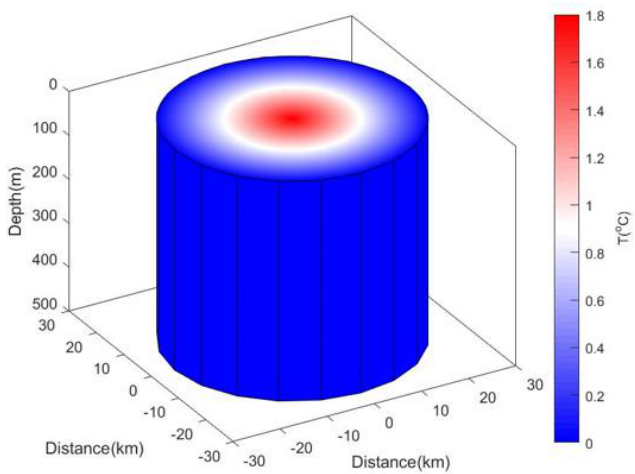
Figure 13. The meddy model with temperature anomaly shown by red circle at the